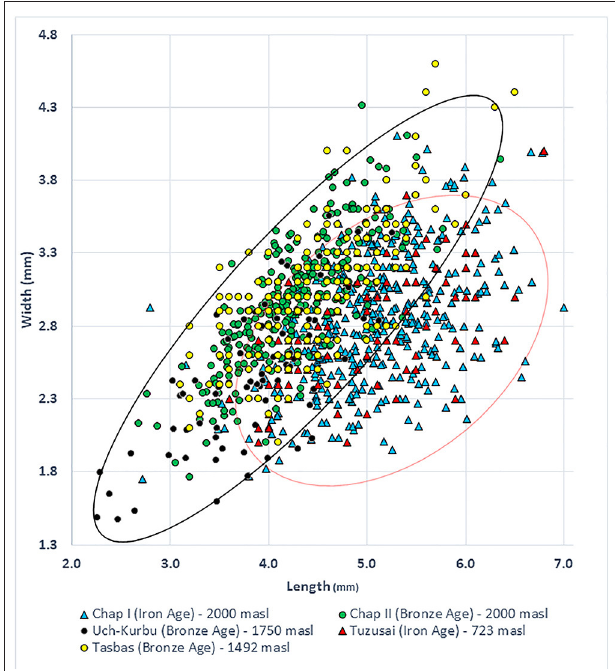
FIGURE 6 | The mean values of barley lengths to widths ratios plotted against the length from archaeological sites in Central Asia.